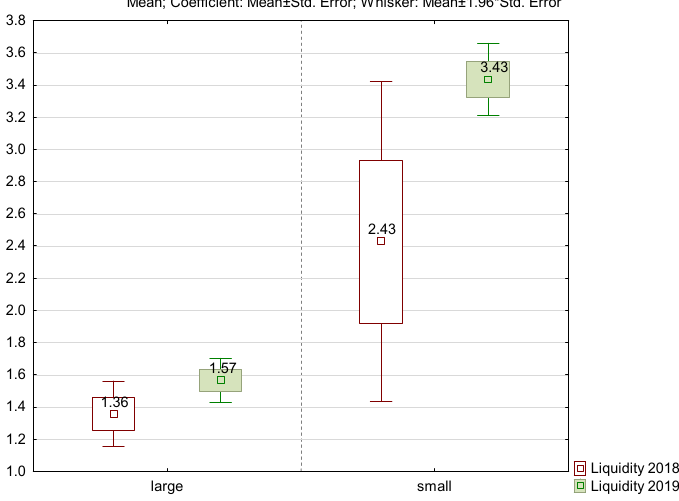
Figure 1. Liquidity in 2018 and 2019 in relation to the size of the company. Mean; Coefficient: Mean±Std. Error; Whisker: Mean±1.96*Std. Error